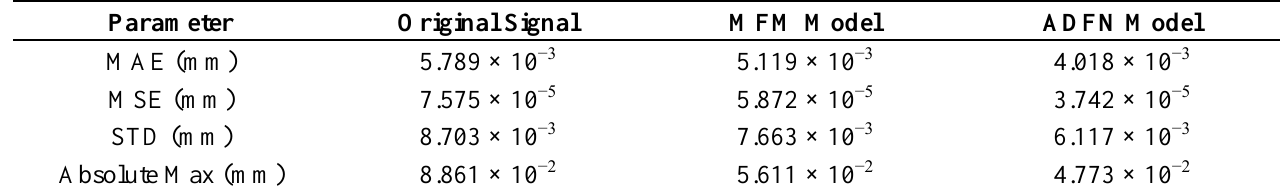
Table 2. Statistical analysis of the short-period displacement component of z